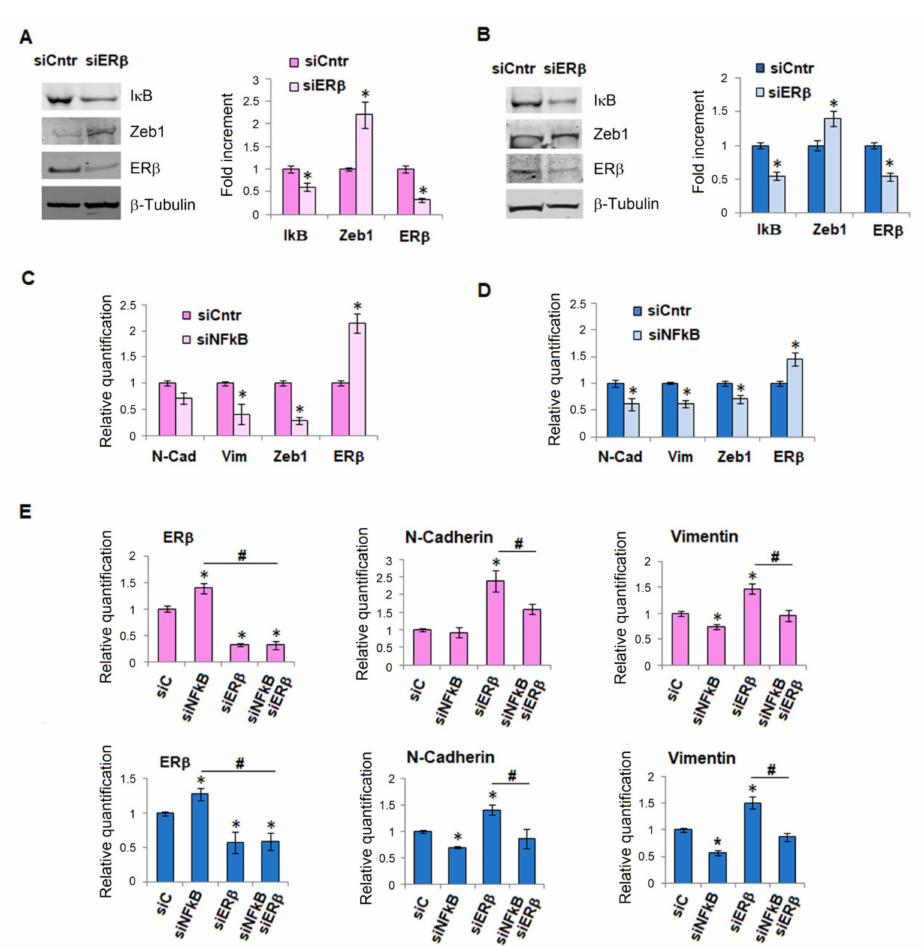
Figure 5. ER β -NFkB crosstalk. IkB, Zeb1, and ER β protein expression performed by Western blotting of female M51 melanoma cells ( A ) and male SSM2c melanoma cells ( B ) ER β silenced. Each band of western blot was quantified by densitometric analysis and the corresponding histogram was constructed relative to β -tubulin. Representative Western blot panels on the left. mRNA expression of ER β and EMT markers in female M51 melanoma cells ( C ) and male SSM2c melanoma cells ( D ) NF- κ B silenced. ( E ) mRNA expression of ER β , N-cadherin, and Vimentin, in M51 and SSM2c melanoma cells silenced for NF- κ B and after 24 h silenced for ER β . Histograms represent the mean ± SEM of at least three independent experiments. * p < 0.05 compared with control cells. # p <